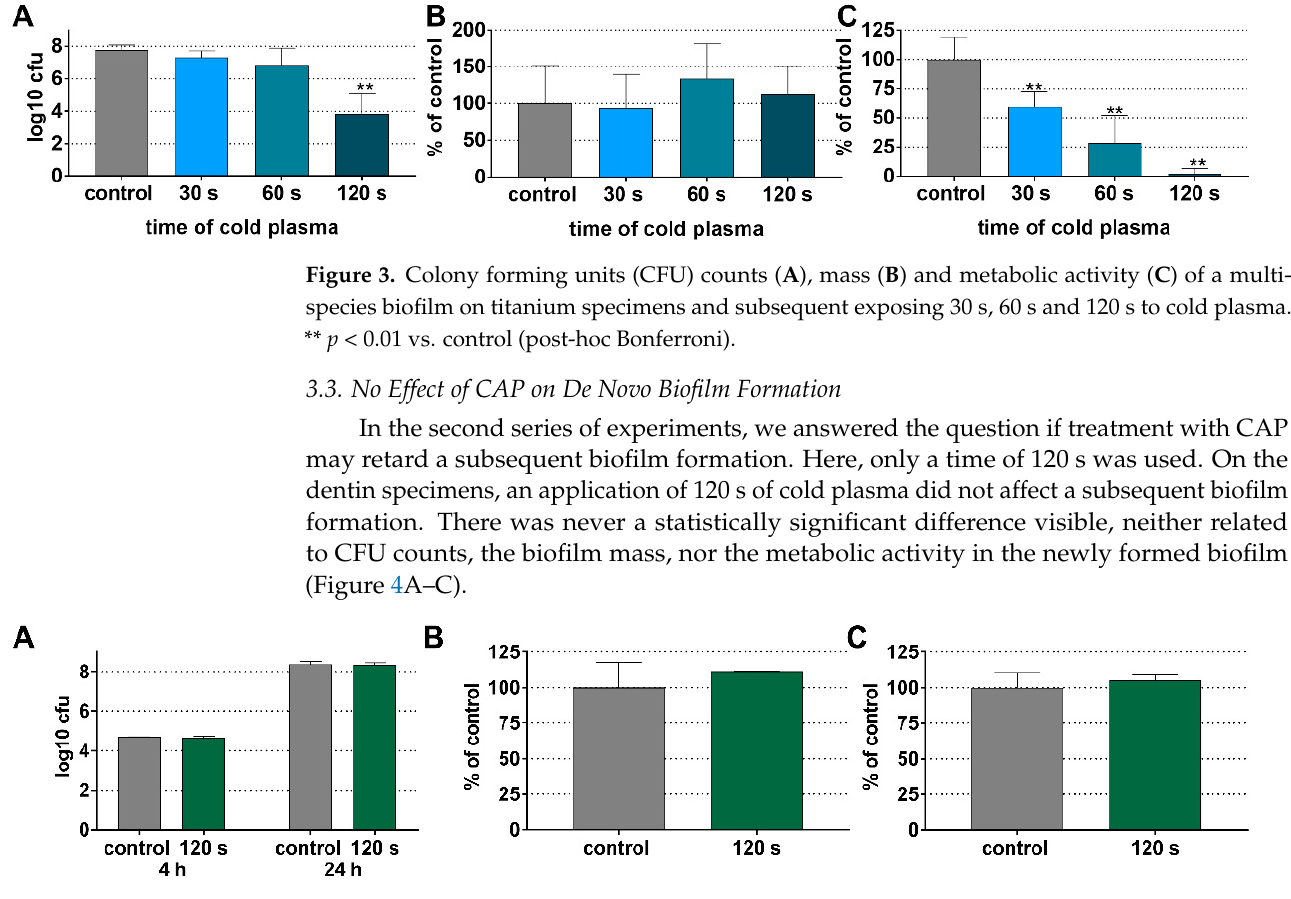
Figure 4. Colony forming units (CFU) counts ( A ) after 4 h and 24 h, mass ( B ), and metabolic activity ( C ) after 24 h of a multi-species biofilm formation on dentin specimens immediately after the application of 120 s of cold plasma .